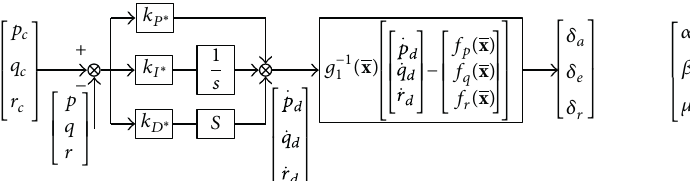
Figure 3: The control structure corresponding to the fast-speed loop.